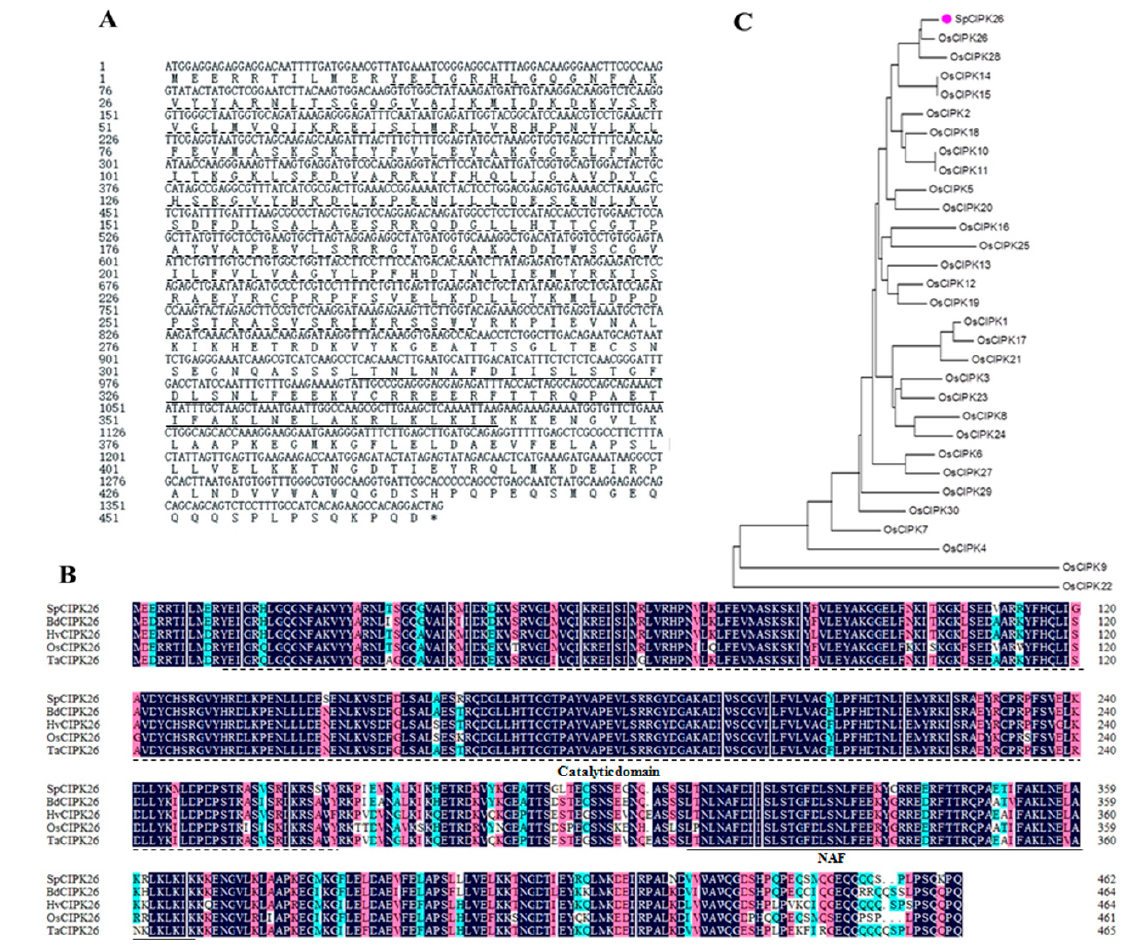
Figure 1. Sequence analysis of SpCIPK26 . ( A ) Nucleotide and deduced protein sequence of SpCIPK26 . Amino acids underlined with solid lines represent NAF domain and marked with dashed line represents catalytic domain; ( B ) alignment of the deduced protein sequence of SpCIPK26 and its homologous amino acids from other plant species. Alignments were performed in MEGA6. Identical amino acid residues are shown in indigo background, amino acid with larger than 75% and 50% identity are shown in cyan and pink, respectively; ( C ) phylogeny of SpCIPK26 and CIPK members of Oryza sativa . Pink dot means SpCIPK26. The phylogenetic tree was constructed in MEGA6 using the putative amino acid sequences.